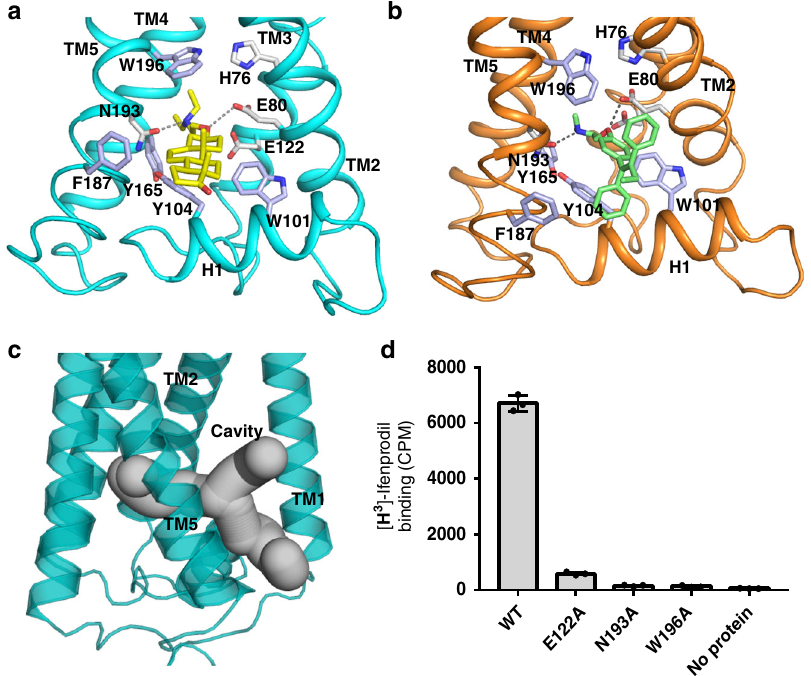
Fig. 3 Molecular mechanism of compound binding to the membrane cavity. a Details of EBP binding to U18666A. The hydrophilic interactions are indicated by dashed lines. The residues related to substrate recognition are shown as sticks. b Details of EBP binding to tamoxifen, annotated as in a . c Overall view of the membrane cavity. d Binding of EBP mutants to [ 3 H]-Ifenprodil. Data shown are the mean ± SD of triple times determinations. Source data are provided as a Source Data fi